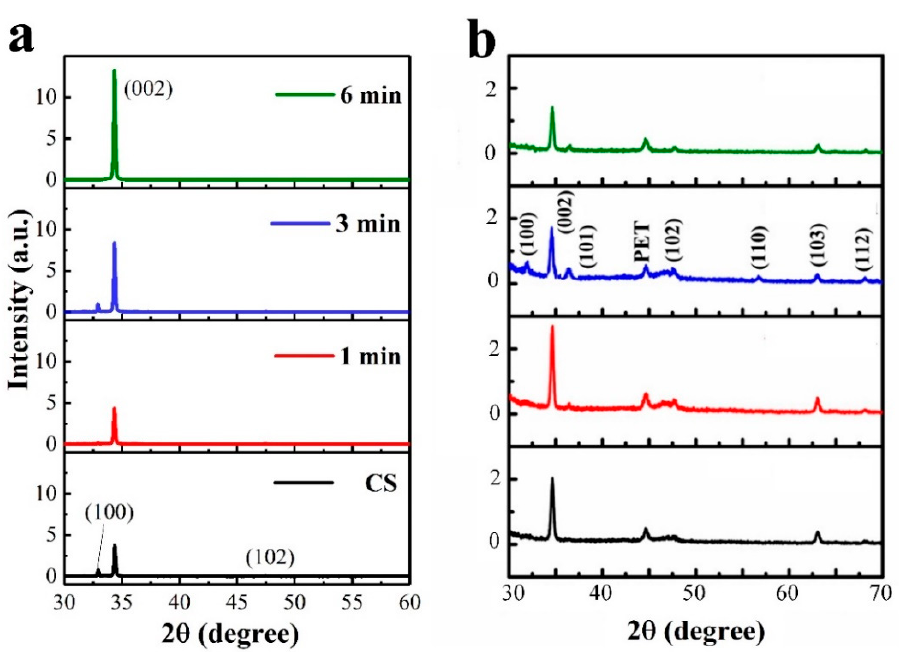
Figure 5. The 2-theta scan patterns recorded from the X-ray diffraction of ZnO NRs with as-grown SLs (CS) and the SLs N 2 O plasma-treated for 1, 3, and 6 min in the cases of growths on ( a ) the GaN and ( b ) PET substrates.